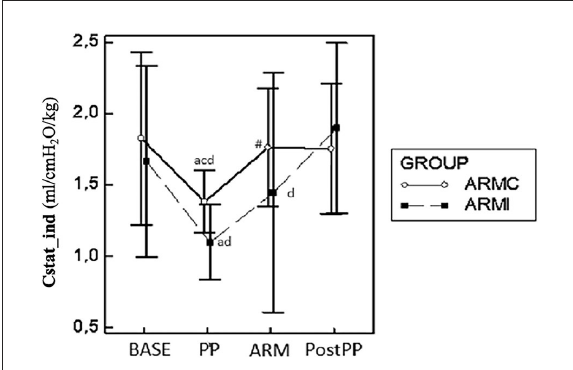
FIGURE1 Graphical representation of the mean ± standard deviation values of C statInd in 20 dogs mechanically ventilated, undergoing laparoscopic surgery. Ten dogs (ARMc) received a “stepwise” ARM, and the other (ARMi) received a “sustained inflation” ARM followed by 5 cmH 2 O of PEEP. The parameters were evaluated 10min before (BASE) and after the induction of PP (PP), 10min after the maneuvers (ARM), and 10min after the discontinuation of PP (Post-PP). # p < 0.05 between the two groups at the same study time. a p < 0.05 in the same group compared with BASE; b p < 0.05 compared with PP; c p < 0.05 compared with ARM; d p < 0.05 compared with